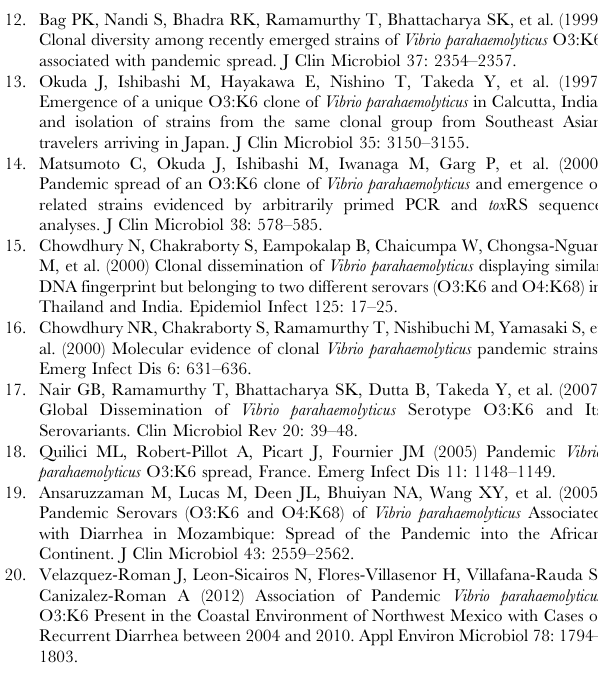
Table S1 Vibrio parahaemolyticus isolate description. Description of the V. parahaemolyticus isolates (N = 167) included in this investigation including source (clinical and environmental), location and date of isolation, and laboratory source. Table S2 REP-PCR results. Summary of REP-PCR results (N = 167 isolates) organized by REP group including the number of isolates in each group and the genotype ( tdh , trh , ureR) of each REP-PCR group. Table S3 MLST and eBURST results. MLST results (N = 77 isolates) organized by sequence type (ST) including the determination of whether a given ST is part of a clonal complex (CC), group (G) or singleton (S) as determined by eBURST.